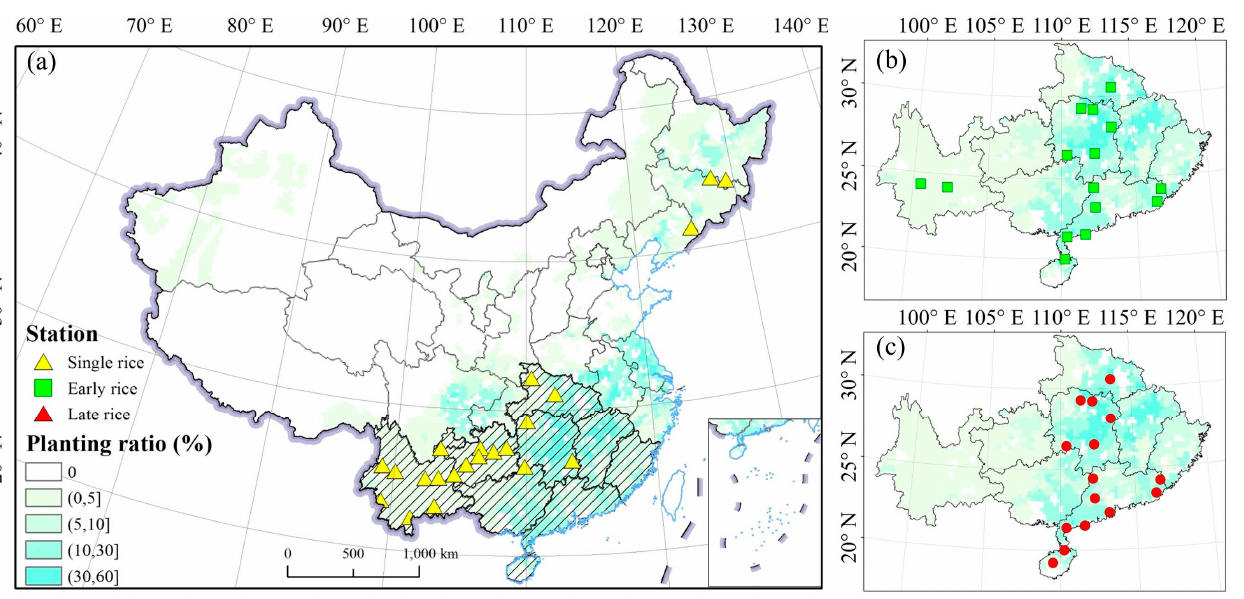
Figure 1. Spatial distribution of rice stations and planting ratio. ( a – c ) Early rice, single rice, and late rice, respectively. The shading in ( a ) indicates the planting areas of early and late